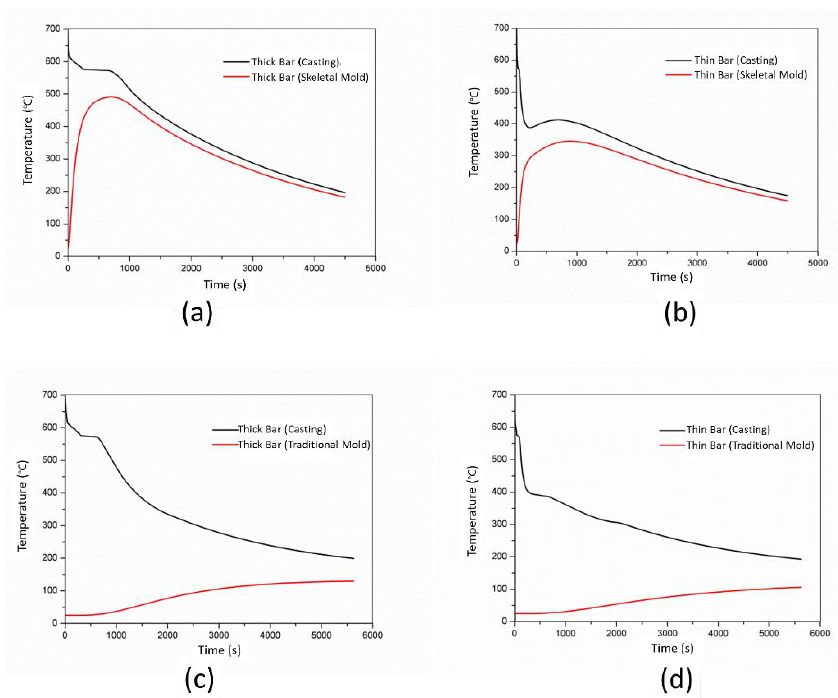
Figure 10. Comparison of the cooling and heating curves of the castings and sand molds: ( a ) thick bar with skeletal sand mold; ( b ) thin bar with skeletal sand mold; ( c ) thick bar with traditional sand mold and ( d ) thin bar with traditional sand mold